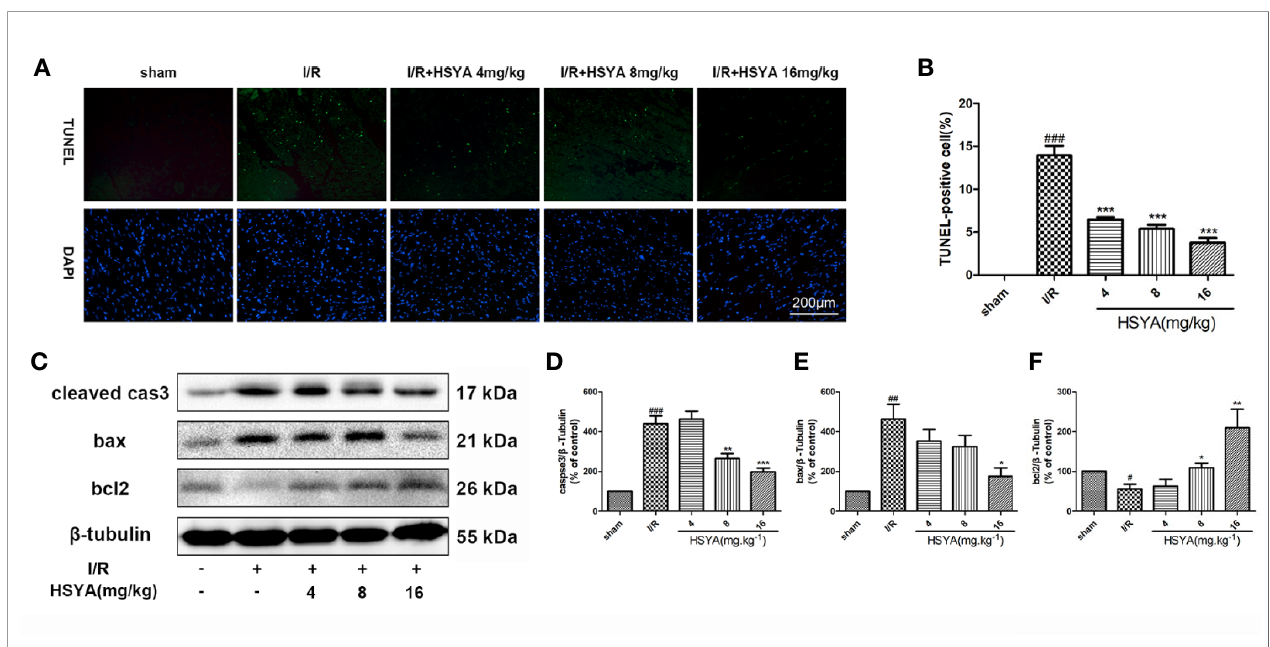
FIGURE 2 | Hydroxysaf fl or yellow A (HSYA) reduces myocardial apoptosis. (A, B) Representative images and analysis results of terminal deoxynucleotidyl transferase-mediated dUTP nick end labeling (TUNEL) staining. Scale bar, 200 m m. (C – F) Representative immunoblots and quanti fi ed analysis of cleaved caspase-3, Bax, and Bcl-2 expression. Data are presented as means ± SEM (n = 3). # P < 0.05, ## P < 0.01, ### P < 0.001 vs . the sham group, *P < 0.05, **P < 0.01, ***P < 0.001 vs . the ischemia/reperfusion (I/R)